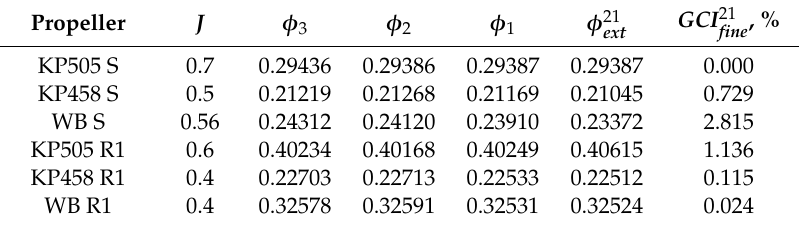
Table 6. The verification study for K QO